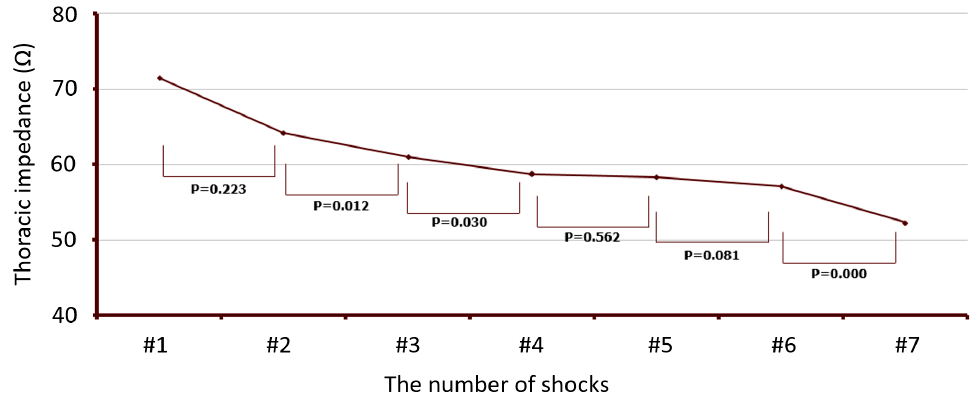
Figure 3. Changes in human impedance with repeated shocks in patients receiving more than three shocks.